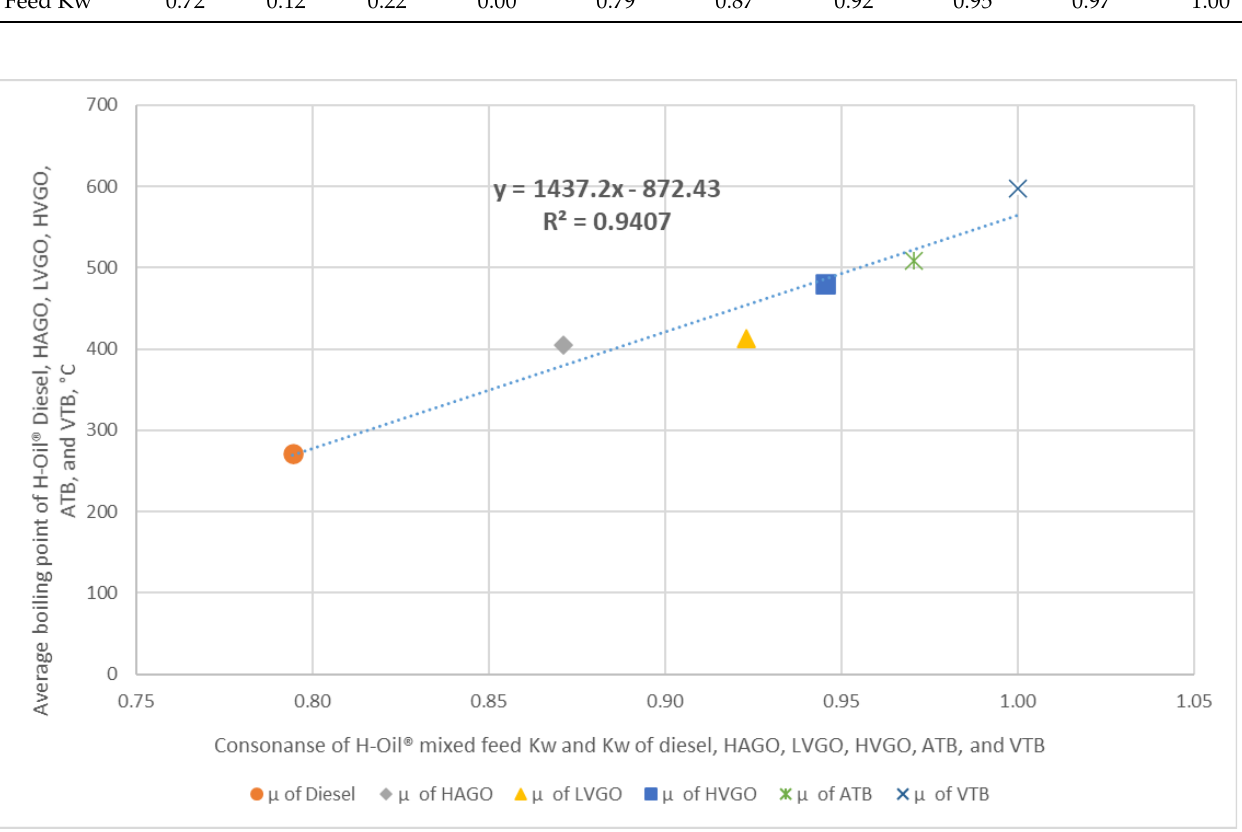
Figure 2. Dependence of the consonanse of mixed feed Kw and Kw of H-Oil ® liquid products on the average boiling point of the liquid products.